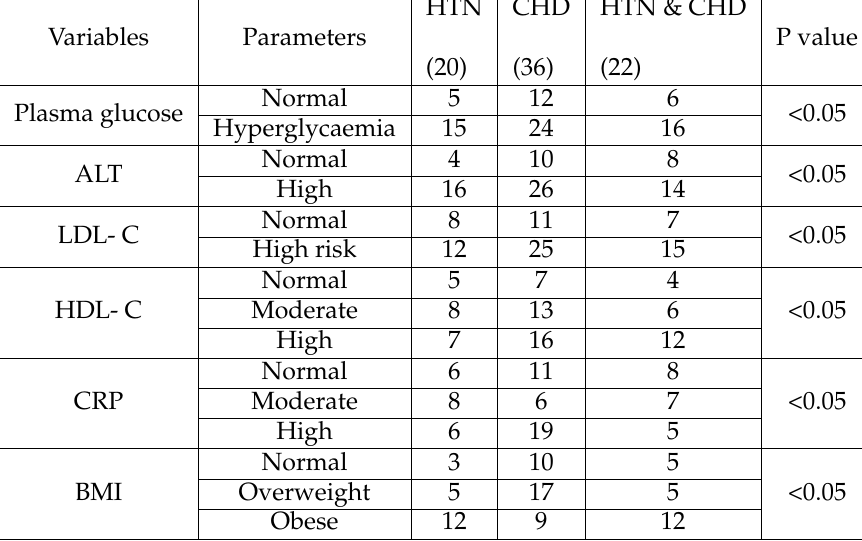
Table 2. Risk factors of CHD and disease